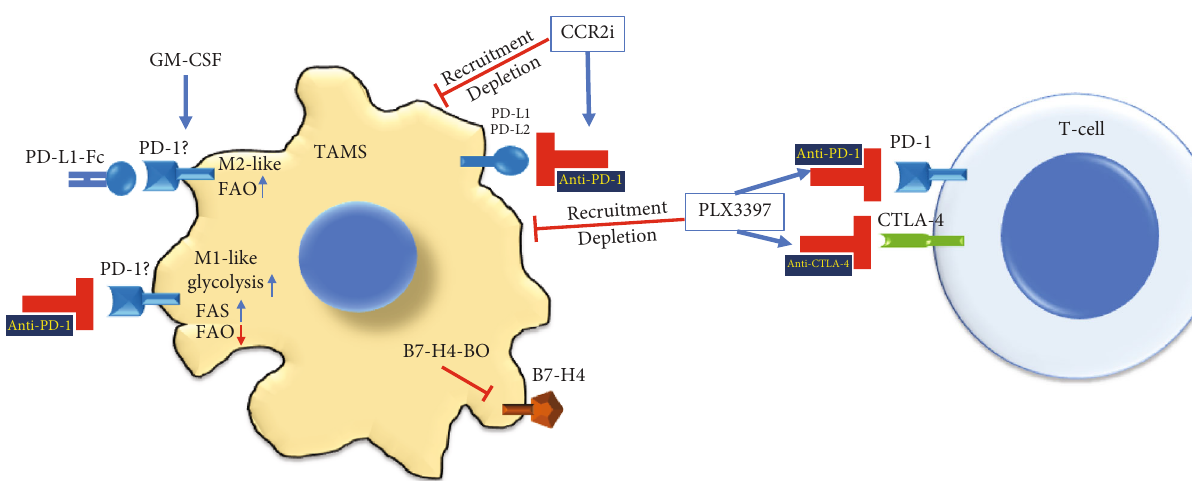
Figure 2: Examples of TAM combinatory targeting with immune checkpoint inhibitors. TAM depletion and recruitment inhibition to the tumor microenvironment, by CCR2 inhibitor or PLX3397, potentiate immune checkpoint inhibition by anti-PD-1, anti-PD-L1/2, or anti- CTLA-4 and further stimulate T-cell functions. Similarly, inhibition of B7-H4 by speci fi c morpholino antisense oligonucleotides (B7-H4- BO) contributes to T-cell stimulation, tumor regression, and tumor growth inhibition. In addition, under GM-CSF-induced macrophages, increased PD-1 expression, and manipulation either with PD-1 agonist (PD-L1-Fc) or with anti-PD-1 may favor the M2-like phenotype or M1-like phenotype, respectively, alongside metabolic reprogramming, which needed to be con fi rmed in TAMs. PD-1: programmed death protein-1; PD-L1: programmed death protein-ligand-1; CTLA-4: cytotoxic T-lymphocyte antigen 4; FAO: fatty acid oxidation; FAS: fatty acid synthesis; GM-CSF: granulocyte-macrophage colony-stimulating